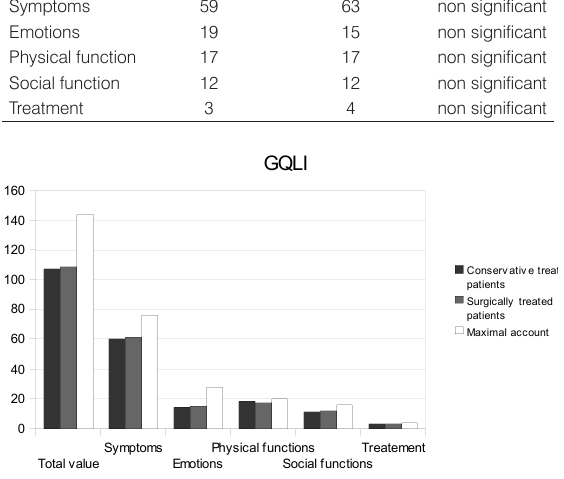
Figure 2. Gastrointestinal Quality of Life Index by conservatively and surgically treated